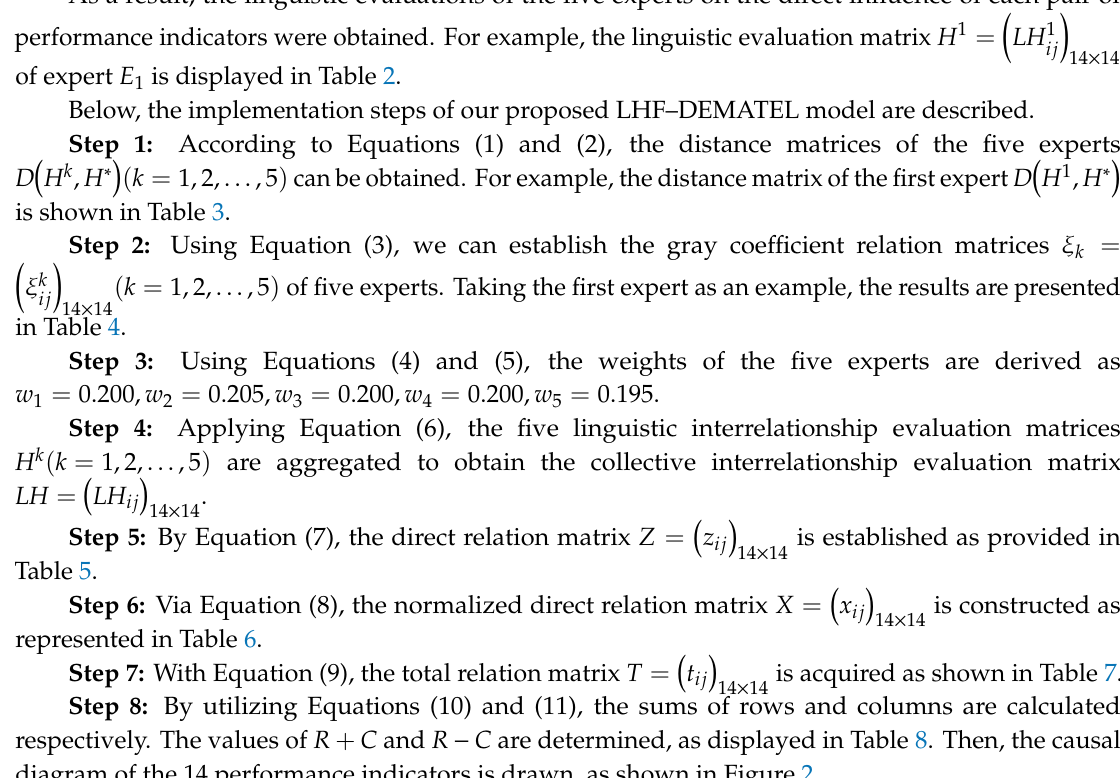
Step 6: Via Equation (8), the normalized direct relation matrix X = represented in Table